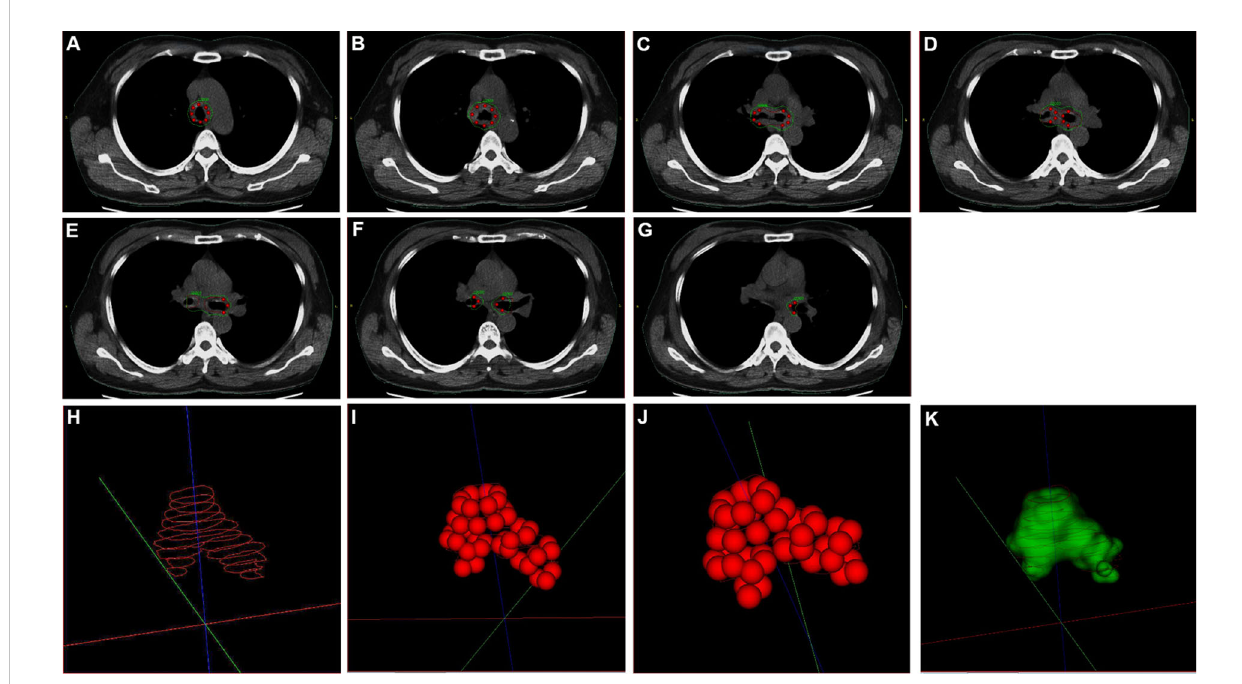
FIGURE 3 The number and distribution of seeds in plan before placement. (A – G) The seeds distribution and isodose distribution in thoracic computerized tomography (CT) scans. (H) Planning target volume (PTV) in three-dimension (3D). (I, J) 125 I seeds distribution in 3D. (K) Isodose cloud of 120Gy in 3D. Red seeds: 125 I seeds. Red curve: target area in planning. Green curve: Isodose curve of 120Gy.